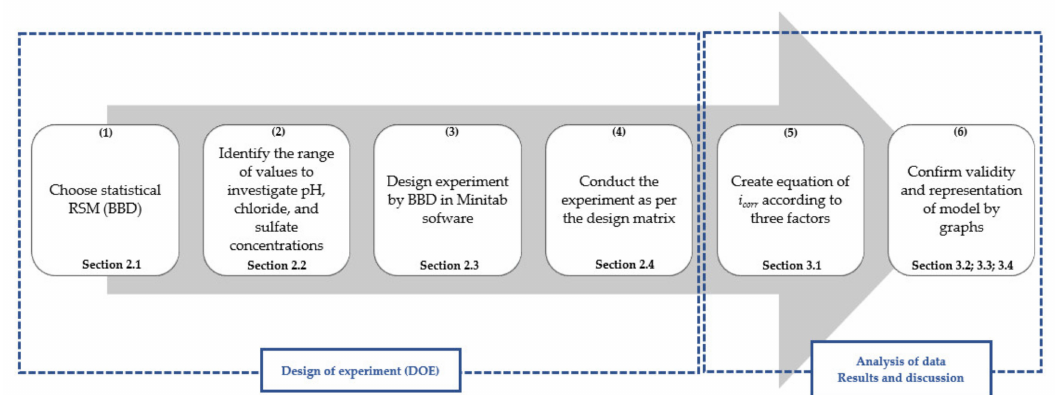
Figure 1. Six steps were implemented to investigate the influence of pH, chloride concentration, and sulfate concentration on the corrosion current density of carbon steel in a soil